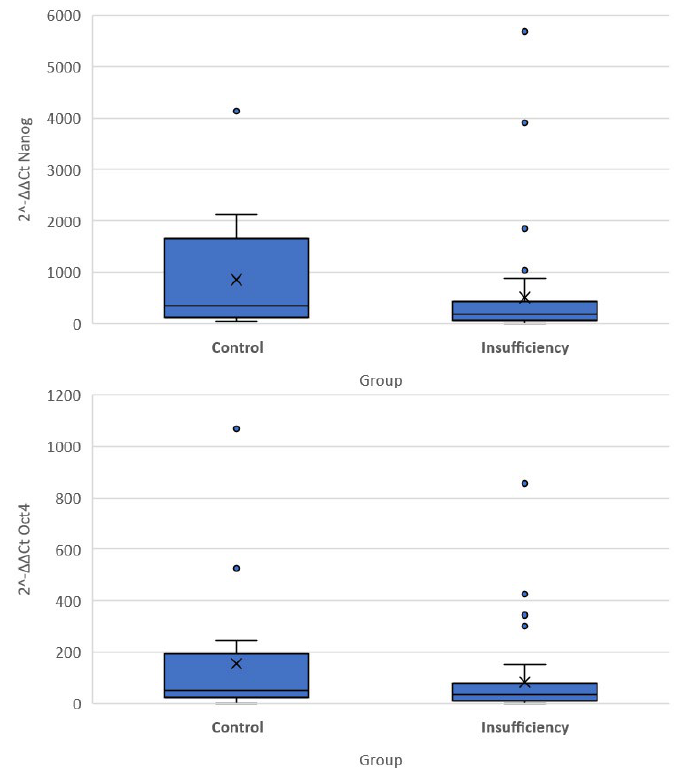
Figure 2. Box plots of 2 − ∆∆ CT values of the Nanog and Oct-4 genes. The Pearson correlation analysis indicated that the correlation of OCT-4 and Nanog expression with cervical length was moderate ( Spearman rho = − 0.387 and rho = − 0.402 , re- spectively). The correlation of DAZL with cervical length was poor ( Spearman rho = 0 .033). The area under the curve for the detection of cervical insufficiency was 0.687 for OCT-4, 0.686 for Nanog, and 0.401 for DAZL, respectively (Figure 3).